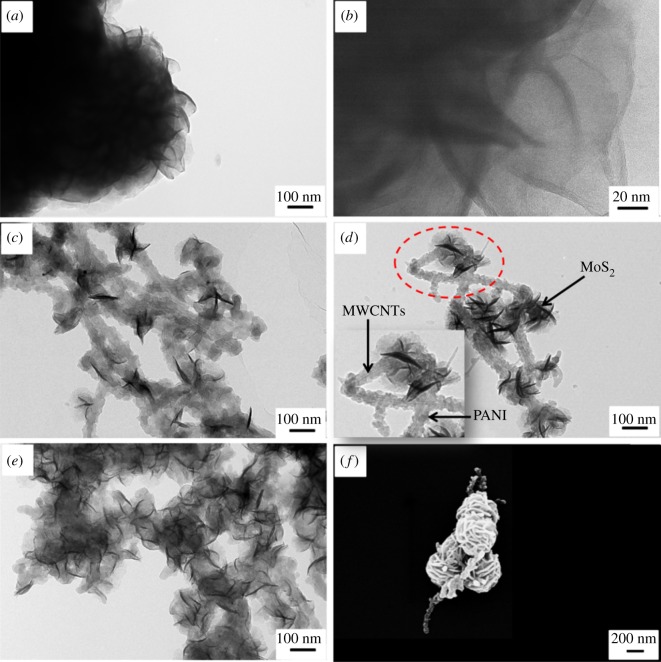
TEM images of (a) MoS2, (b) high magnification of MoS2, (c) MPM-0.06, (d) MPM-0.1, (e) MPM-0.14. (f) SEM image of MPM-0.1.